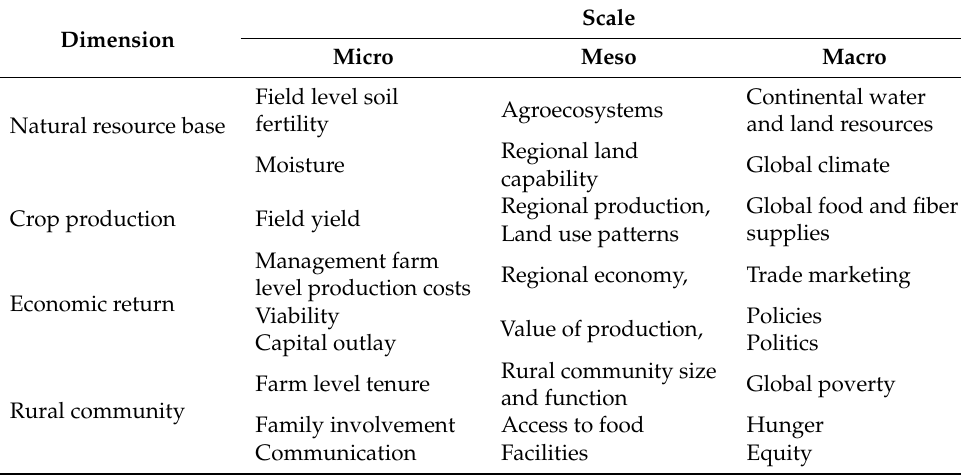
Table 1. Micro, meso, and macro level of sustainable agriculture.